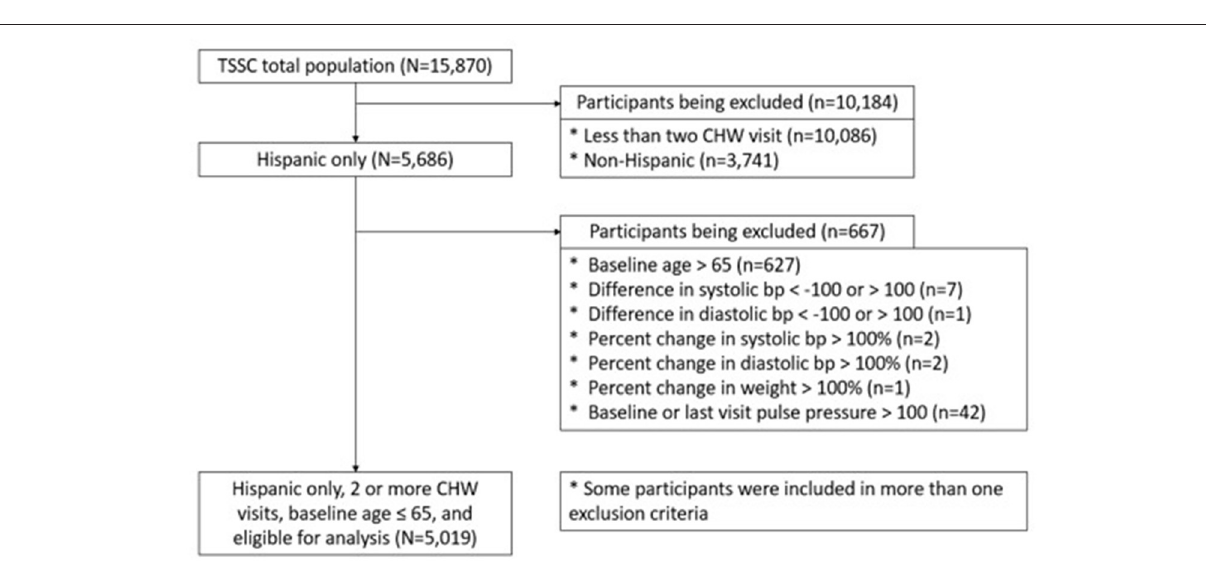
FIGURE 3 | Flowchart for the selection of the study’s